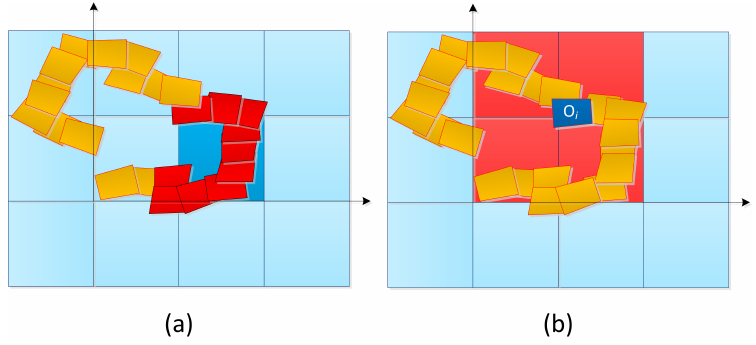
Figure 9. The overall mosaic is created as a grid of patches. In ( a ), the blue patch intersects all the red orthoframes; In ( b ), the current frame O intersects the red patches and, therefore, will be added to their reference